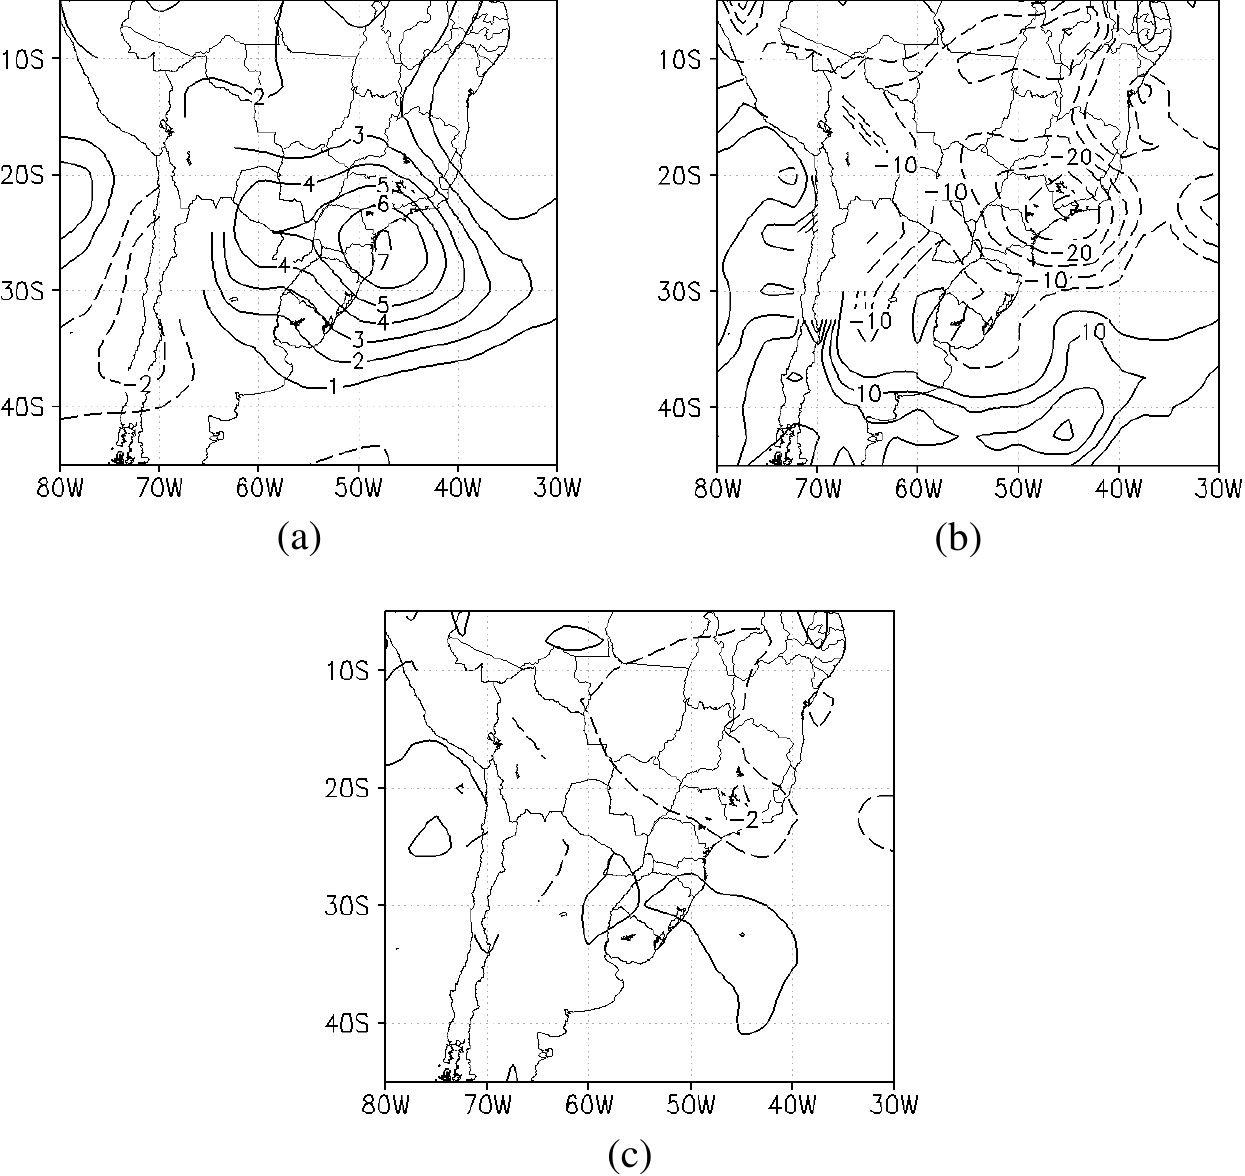
Fig. 8. Episode-mean anomaly fields for Case 29 (27 August through 10 September 1999) of (a) temperature ( ◦ C), (b) relative humidity (%), Fig. 8 – Episode-mean anomaly fields for Case 29 (27 Aug through 10 Sep 1999) of (a) and (c) specific humidity (gkg − 1 ) at 850hPa. Broken lines indicate negative temperature ( ° C), (b) relative humidity (%), and (c) specific humidity (g kg -1 ) at 850 hPa. Broken lines indicate negative values.